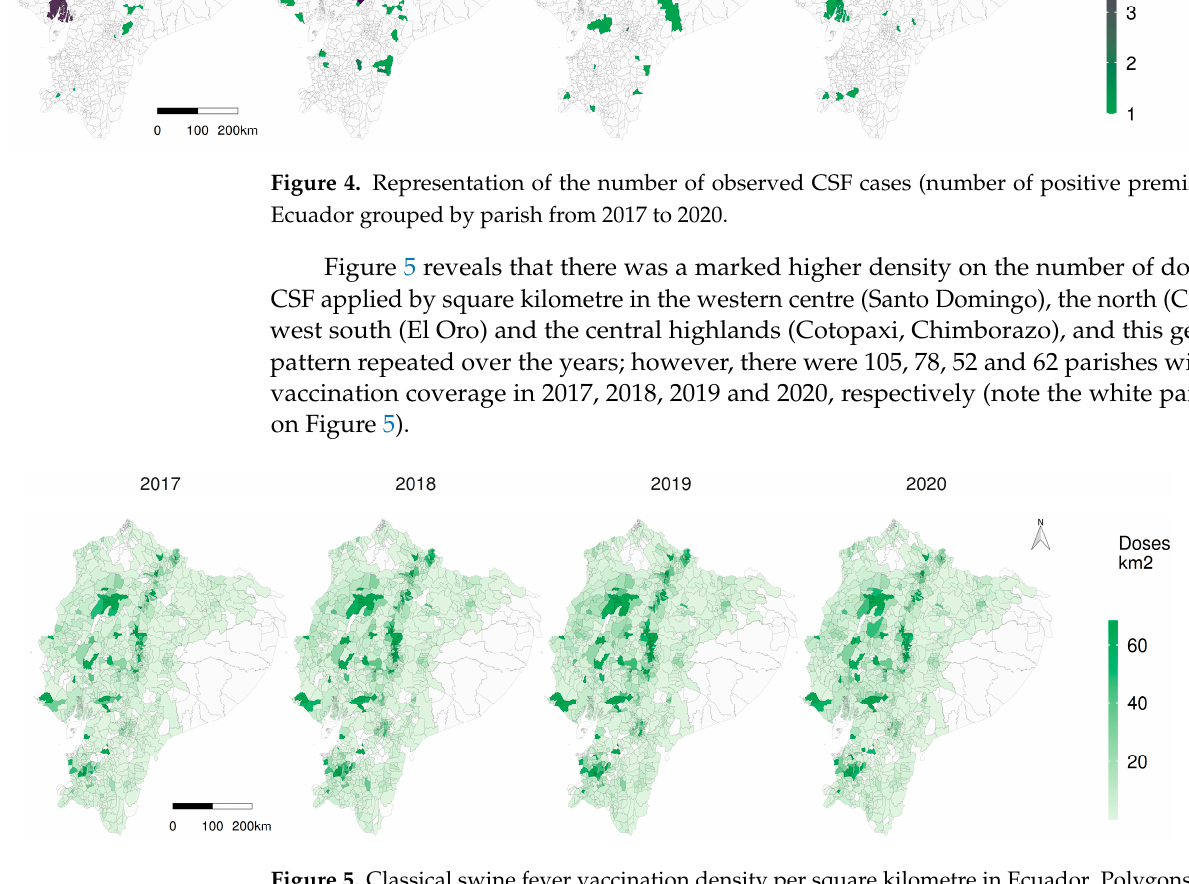
Figure 5. Classical swine fever vaccination density per square kilometre in Ecuador. Polygons of the parishes on the map. White parish without applied doses.